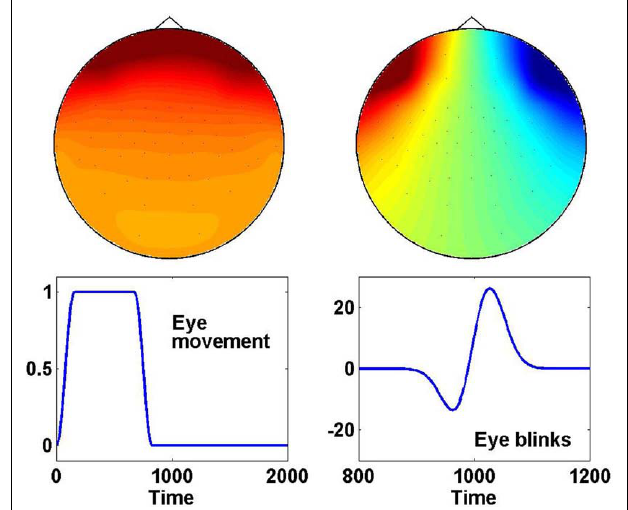
FIGURE 12 | (Data Set 1 – artificial). Spectra of the EEG signal in two discriminative channels.The discriminability between the classes is shown at the bottom of each spectrum.This Figure illustrates an example of asymmetry of the µ rhythm peak in each hemisphere. Also the harmonic of the µ rhythm is observable in the beta band.